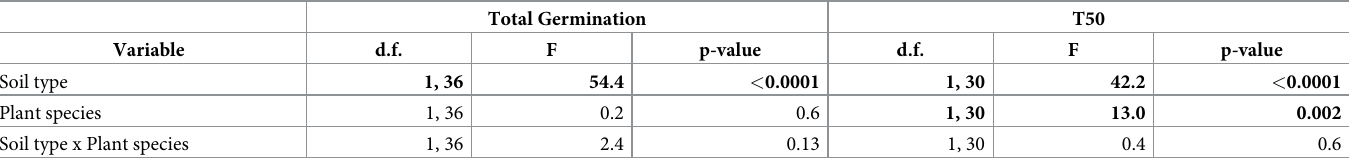
Table 1. Analysis of variance comparing the effects of soil type (crusted versus uncrusted) and plant species (bush clover versus lupine), and their interaction, on total germination and time to 50% of total germination (T50).